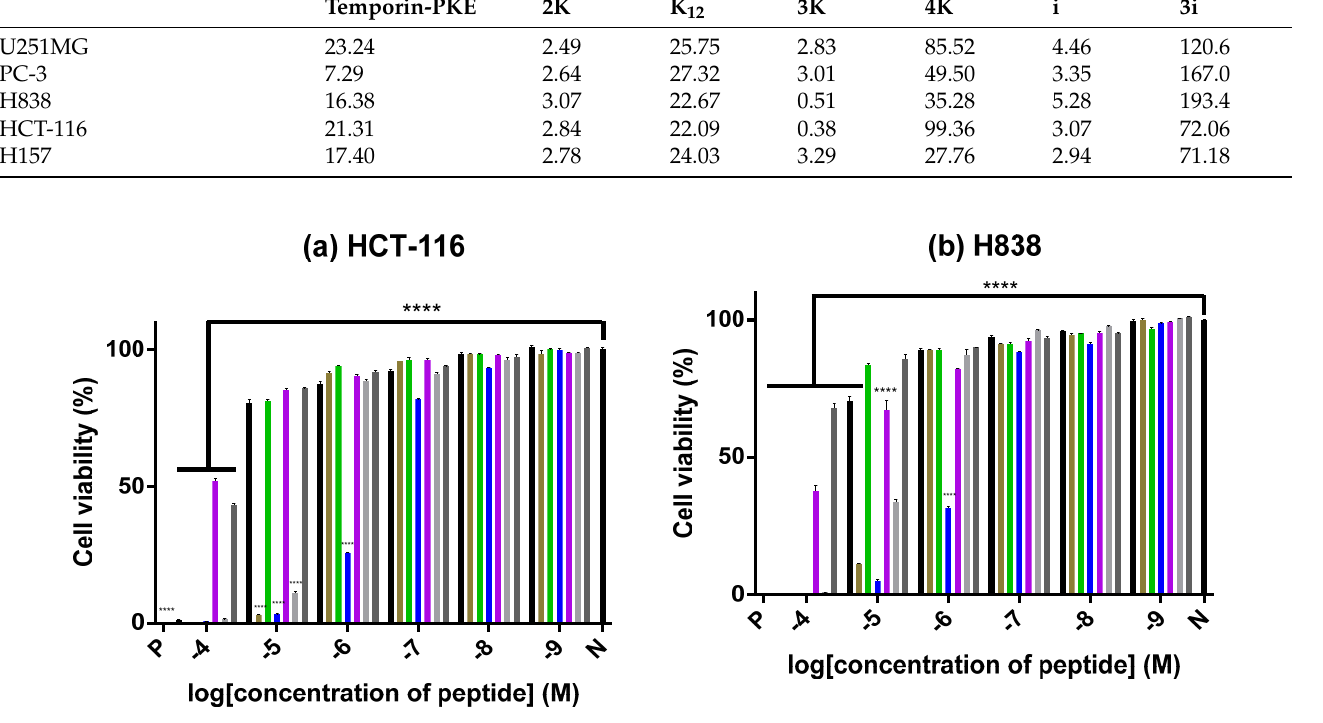
Cancer Cell Lines